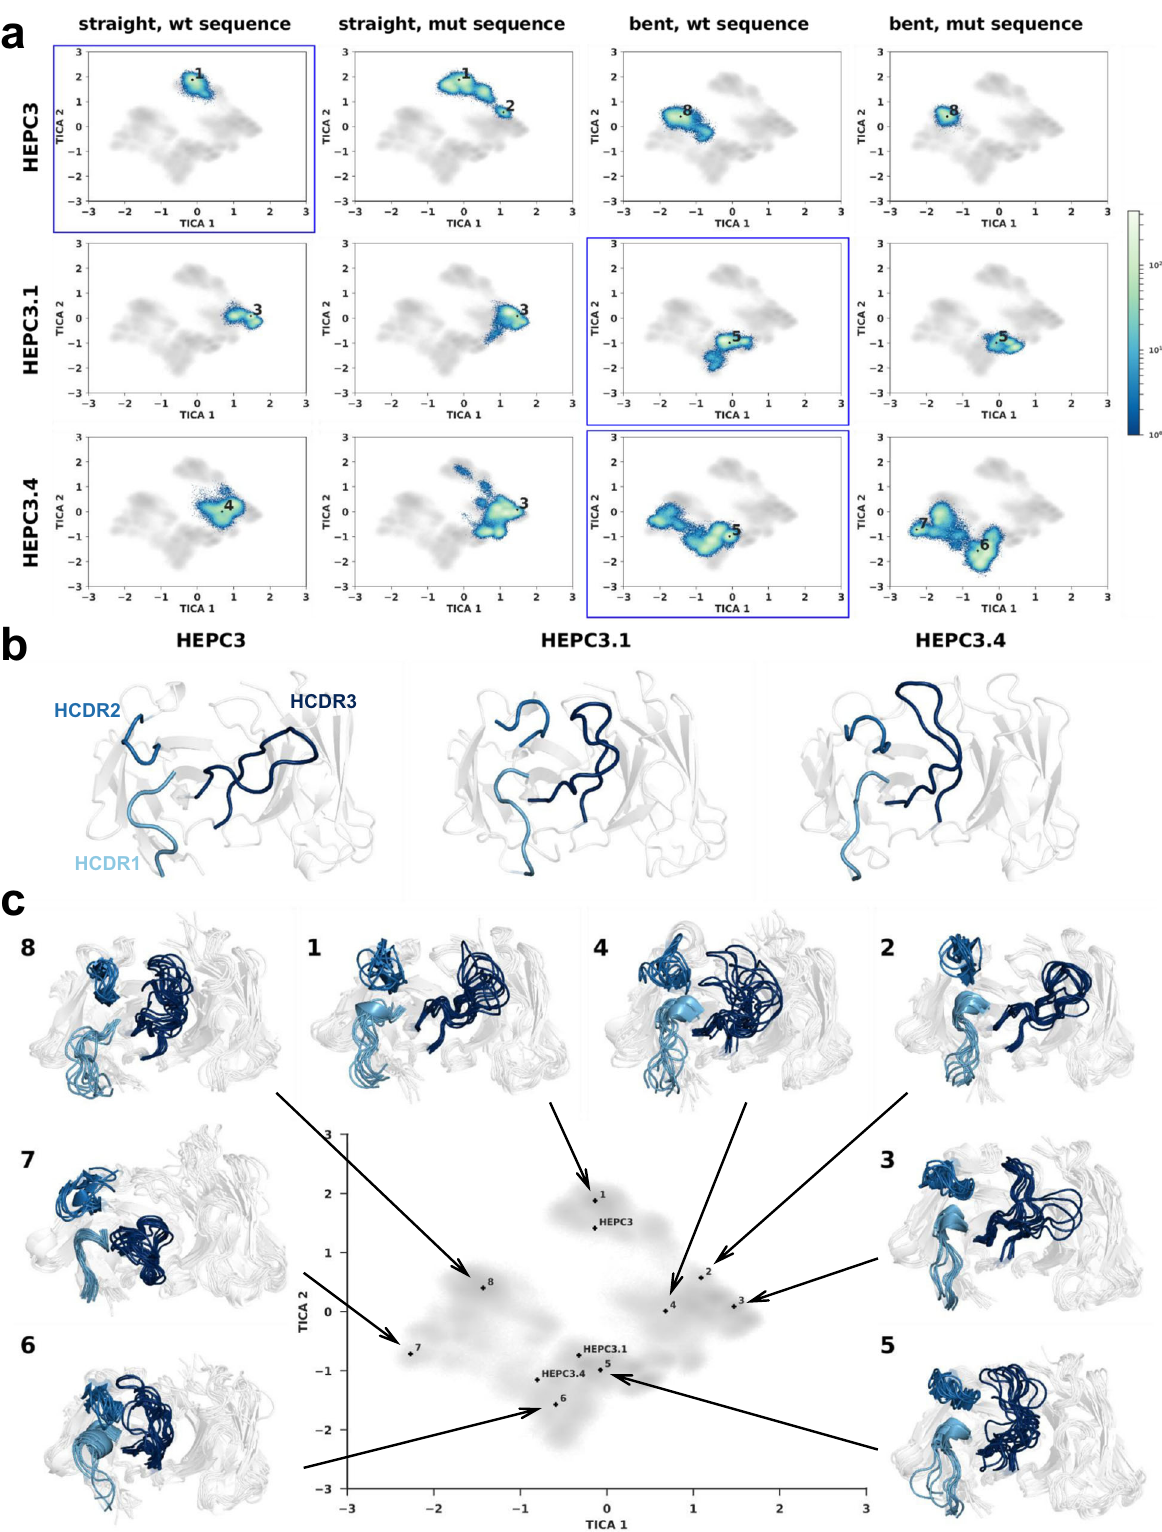
Fig. 6 HCDR3 loop conformational dynamics. a 2D-histograms of individual Ab simulations projected onto the fi rst two time-lagged independent components of the combined Ab TICA-transformed conformational space. Histograms corresponding to simulations initialized with the crystallographic conformations are outlined in blue. b Cartoon representation of the structures of the Abs HEPC3, HEPC3.1, and HEPC3.4 as observed in the crystal structures of the apo Fabs. HCDR1, HCDR2, and HCDR3 loops are colored light blue, blue, and dark blue, respectively. c Ensembles of 10 structures from representative conformational clusters. Structures are shown as cartoons. HCDR1, HCDR2, and HCDR3 loops are colored light blue, blue, and dark blue, respectively. Numbers in ( a ) and ( c ) correspond to minima sampled to display